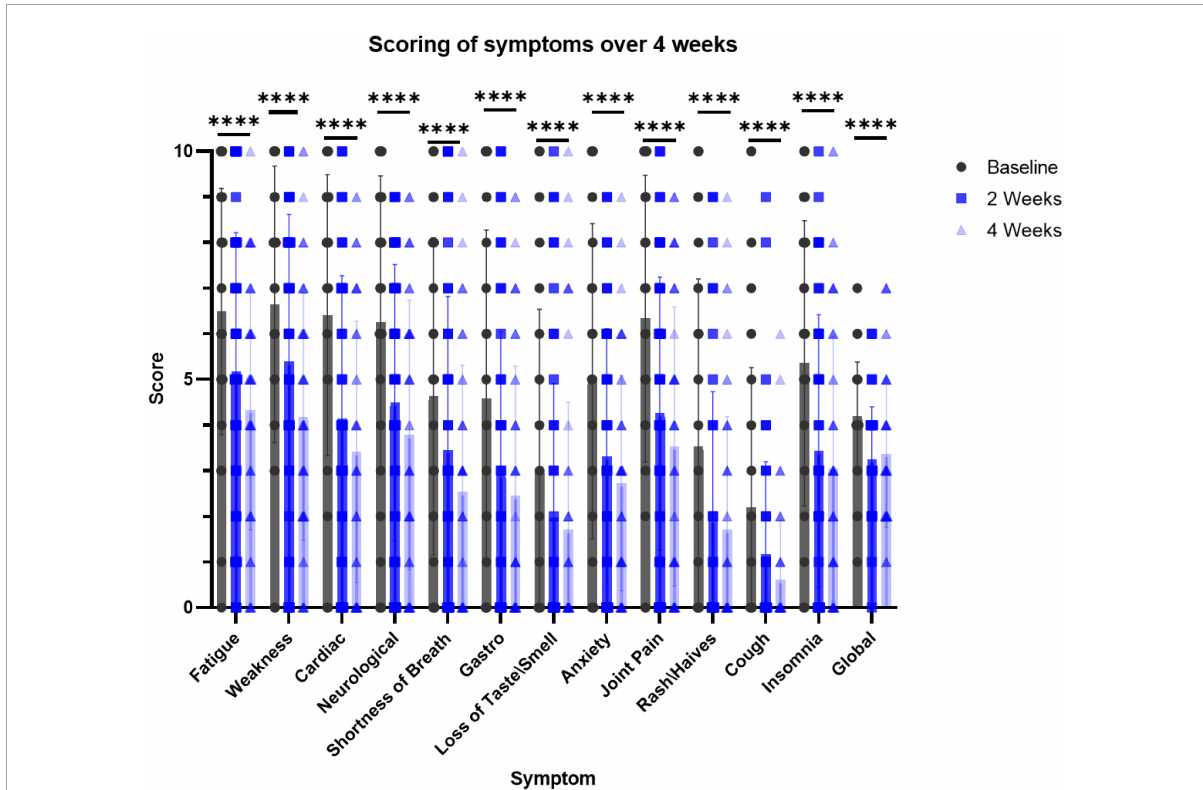
FIGURE3 Survey-based scoring by participants at the intake to the trial (baseline), 2 and 4 weeks while taking the supplement. N = 51. Dunnett’s multiple comparisons test, p < 0.0001 in 2 and 4 weeks for the effect of the supplement on all the symptoms (vs. baseline). ∗∗∗∗ p < 0.006 paired t -test, at 2 weeks vs. baseline and 4 weeks vs. baseline for each symptom.